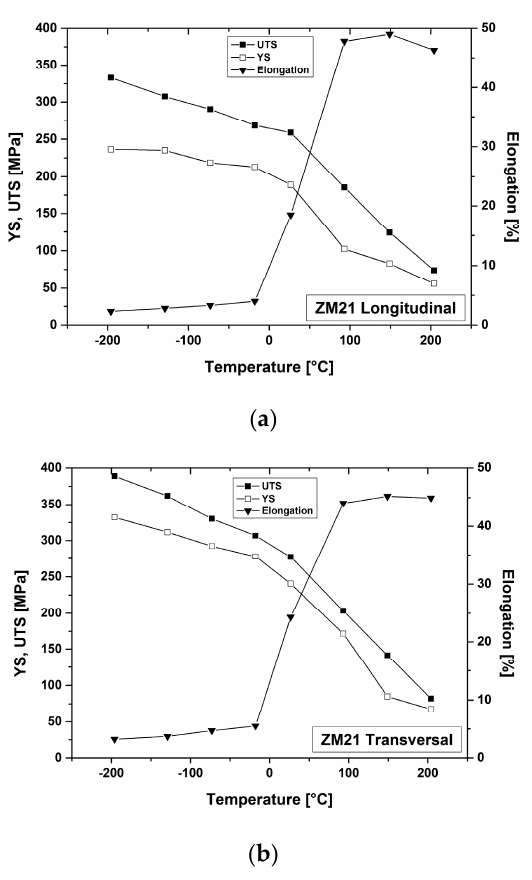
Figure 8. Mechanical properties of ZM21 sheets in ( a ) longitudinal and ( b ) transversal directions (redrawn from [22]). Table 7. Chemical composition of casting alloys, sheet alloys, and extrusion alloys [1].